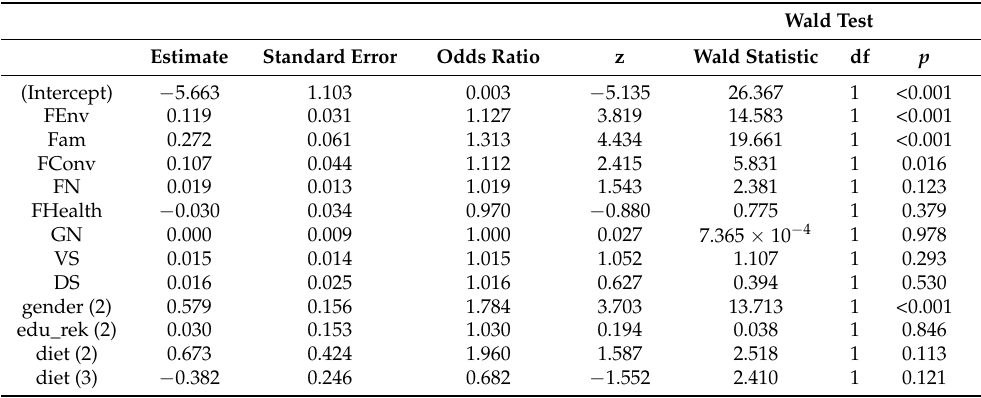
Table 3. Results of binary logistic regression model explaining consumers’ acceptance of the idea of insects as meat